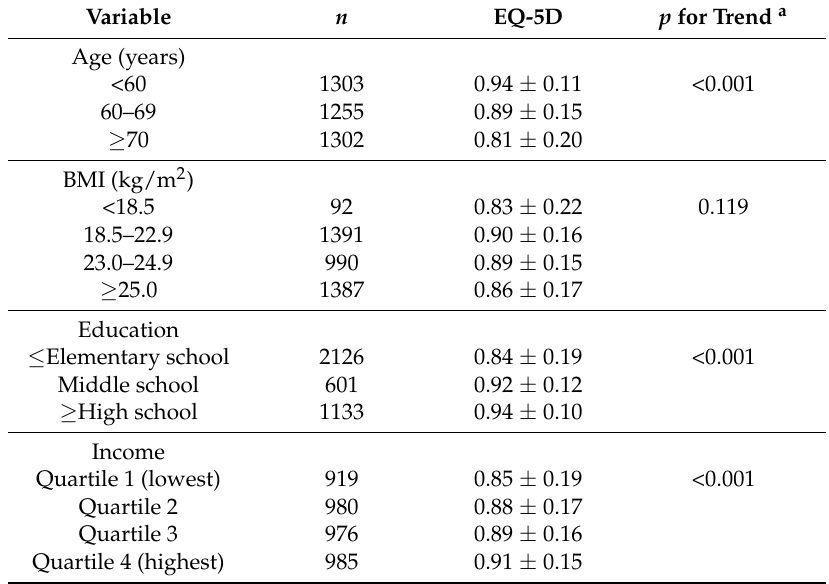
Table 2. Mean EQ-5D scores of postmenopausal women according to demographic characteristics.